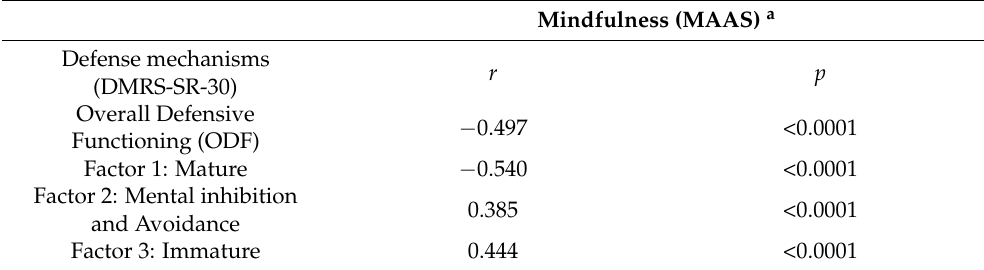
Table 2. Pearson correlations between mindfulness disposition and defense mechanisms (N = 6385).